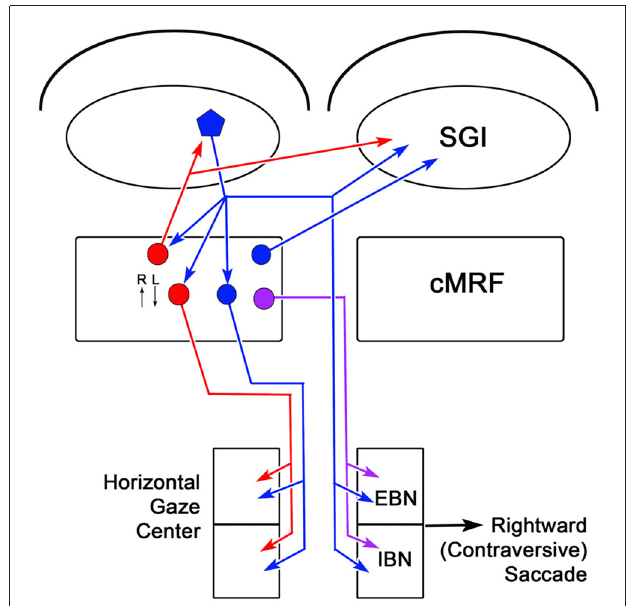
FIGURE 14 | Circuit diagram showing the cMRF as a conduit for collicular influence on lower brainstem centers. Connections from the left side of the midbrain that would produce rightward (contraversive) saccades are shown. Neurons located in the cMRF receive direct input from the SGI of the SC and forward a signal to the horizontal gaze center, the brainstem center that controls horizontal saccadic eye movements. The horizontal gaze center contains both excitatory burst neurons (EBNs) and inhibitory burst neurons (IBNs) that are premotor cells projecting to the ipsilateral and contralateral abducens nucleus, respectively. Axons of collicular neurons (blue pentagon) that travel via the predorsal bundle, provide collaterals to the ipsilateral cMRF before crossing and terminating in the horizontal gaze center. The cMRF contains both inhibitory (red circle) and excitatory (blue circle) cells that project to the ipsilateral horizontal gaze center. In addition, it contains a population of cells (purple circle) that project to the contralateral horizontal gaze center. The cMRF also provides feedback to the SC, which is purely inhibitory (red circle), ipsilaterally, and both inhibitory and excitatory (red and blue circles, respectively), contralaterally. The activity of cMRF neurons for rightward (R) and leftward (L) saccades is indicated by small